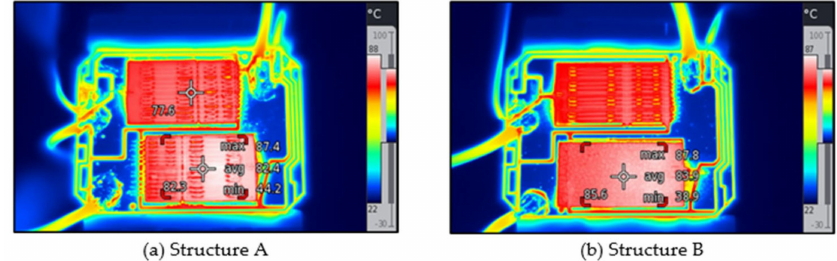
Figure 6. Infrared thermographic images with load currents at ( a ) 6.2 A and ( b ) 6.4 A.